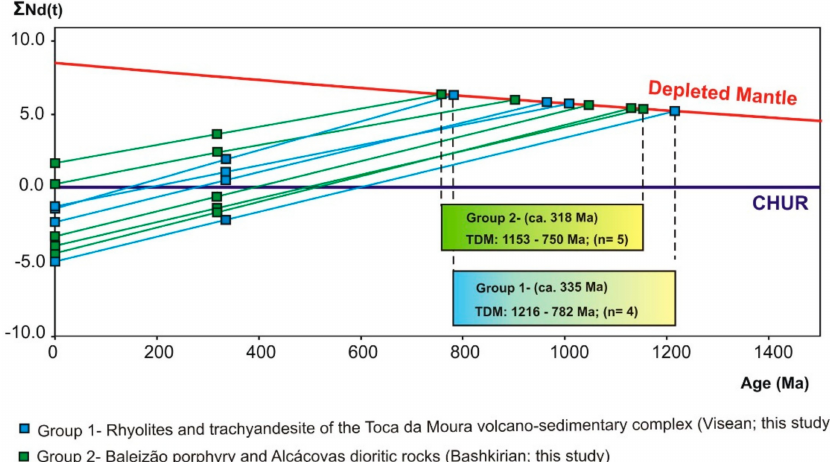
Figure 6. Nd T DM model ages [53] for the Toca da Moura (Group 1) and Baleiz ã o-Alc á çovas (Group 2) igneous